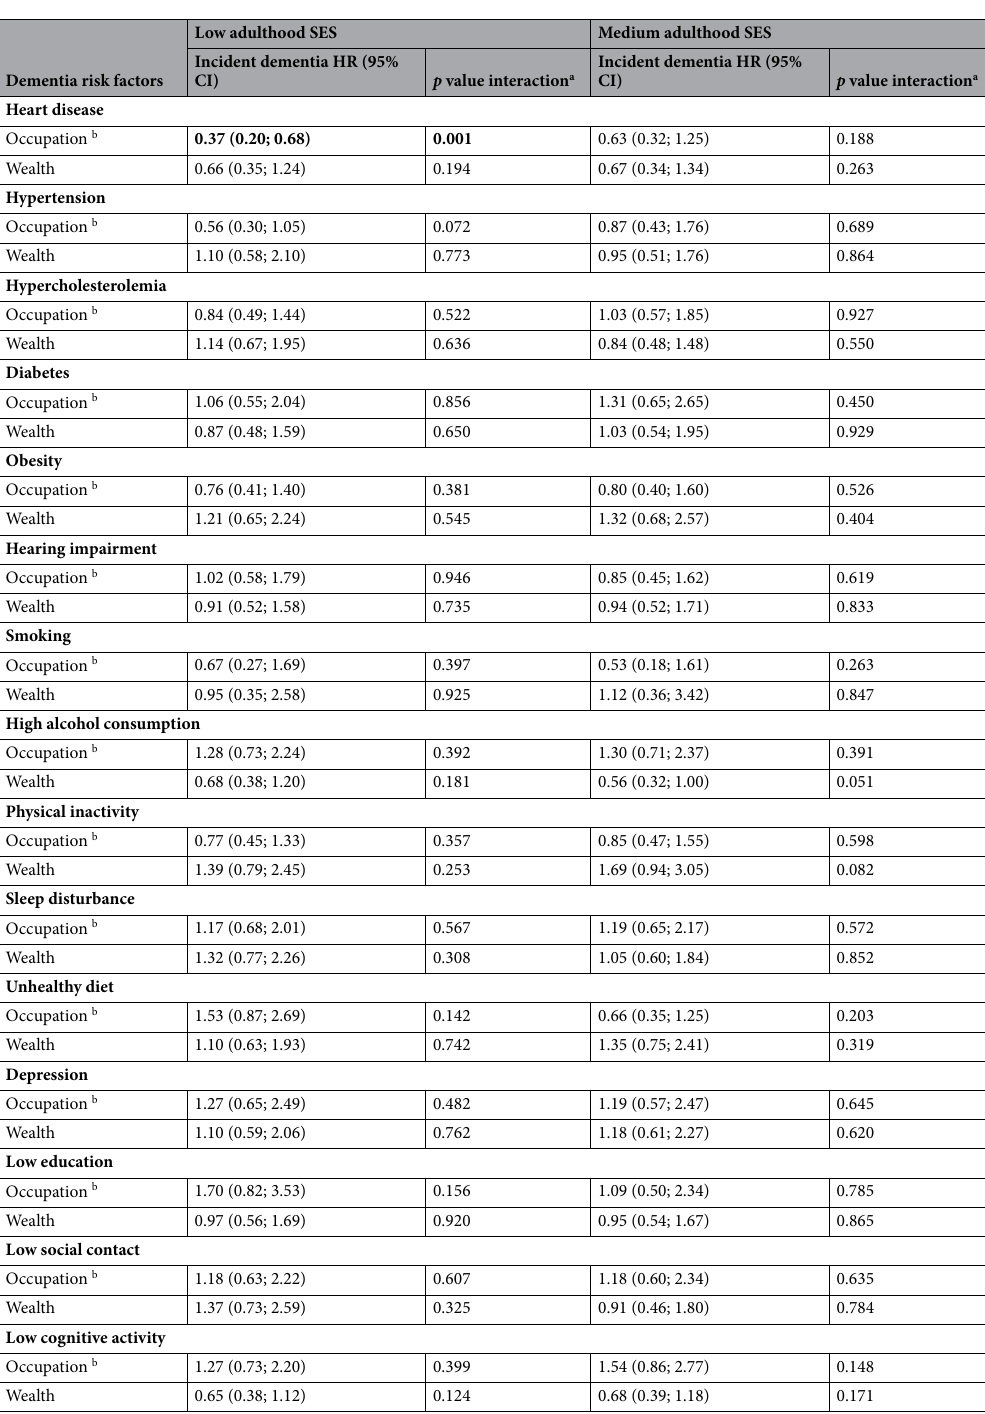
Table 5. Interactions of dementia risk factors with indicators of adulthood socioeconomic status (occupation low/medium/high; wealth low/medium/high) on dementia risk. Low occupation n = 3508 (181 dementia cases) and medium occupation n = 2251 (111 dementia cases). Low wealth n = 2930 (167 dementia cases) and medium wealth n = 3047 (129 dementia cases). SES socioeconomic status; HR hazard ratio; CI confidence interval. Analyses are adjusted for age, sex/gender, and clustering at the household level. a Interaction of risk factor with adulthood SES with high adulthood SES as reference category ( n = 2964 for wealth [100 dementia cases] and n = 3028 for occupation [92 dementia cases]). b Data missing in n = 151. Significant values are in